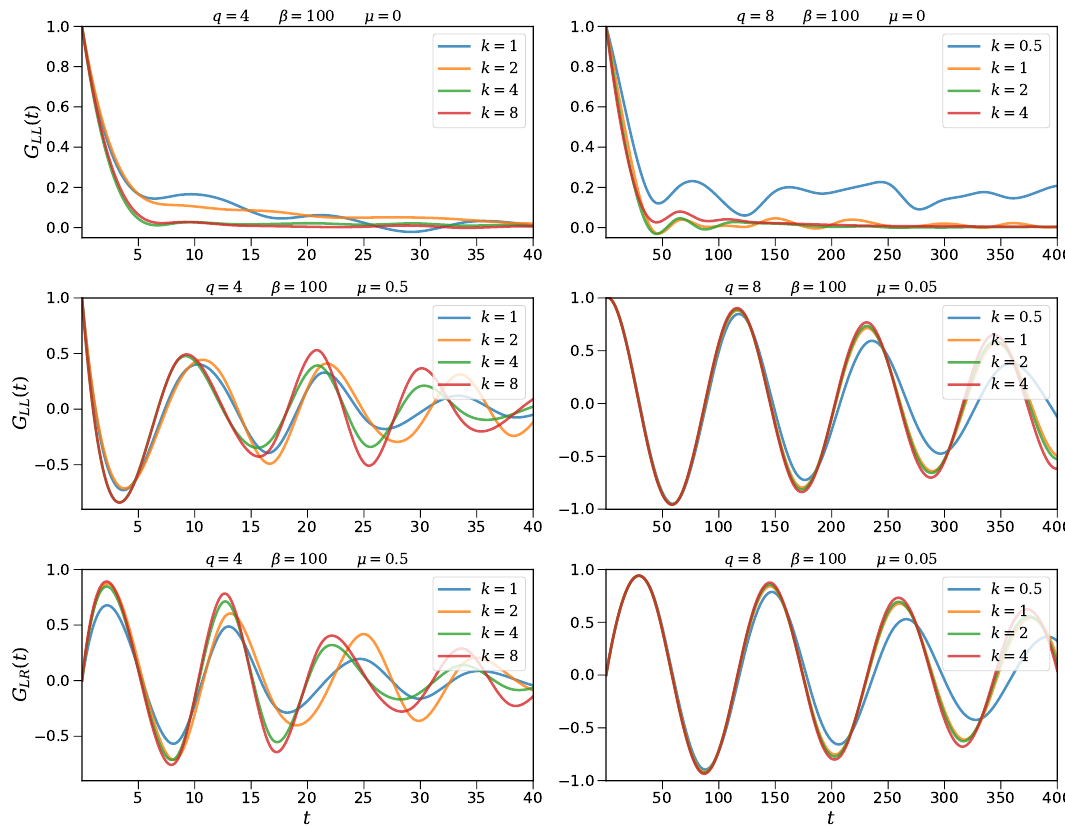
Figure 4. Real time retarded Green’s function G ab ( t ) (4.5) with 2 N = 40 , q = 4 (Left) and q = 8 (Right), for different choices of the sparsity parameter k . Each curve is an average over 50 disorder realizations of the random couplings. For µ = 0 , the left-right correlator G LR (not shown)